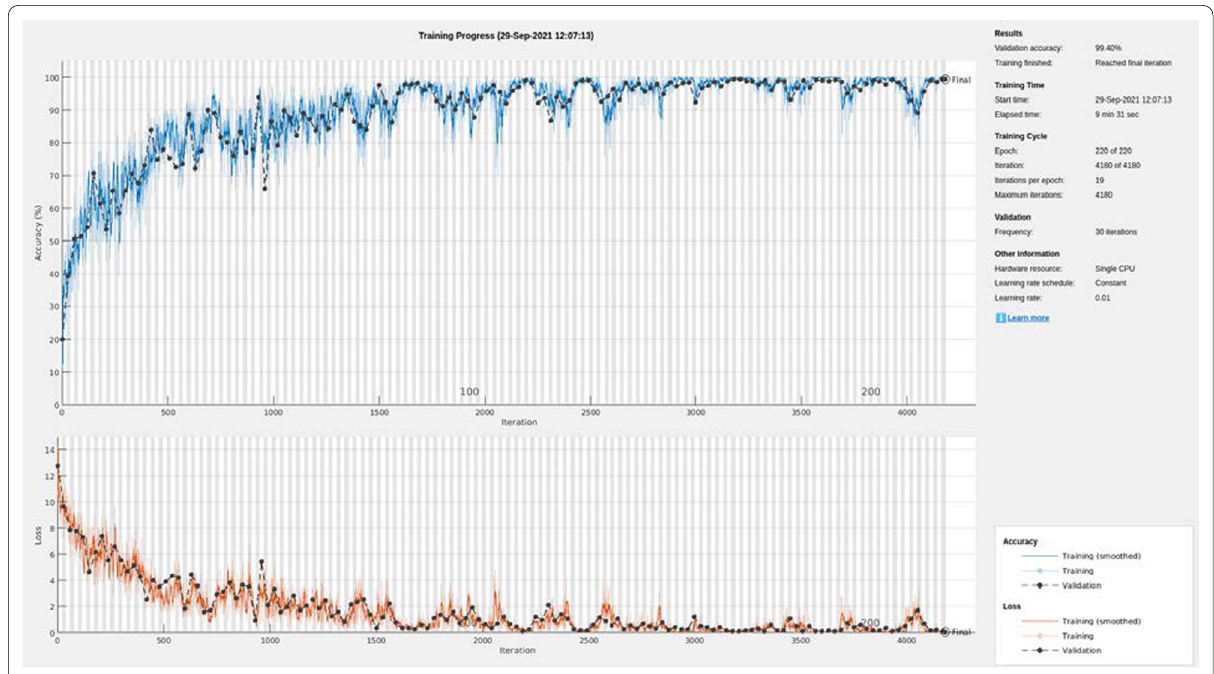
Fig. 10 Training and testing performance of AlexNet architecture